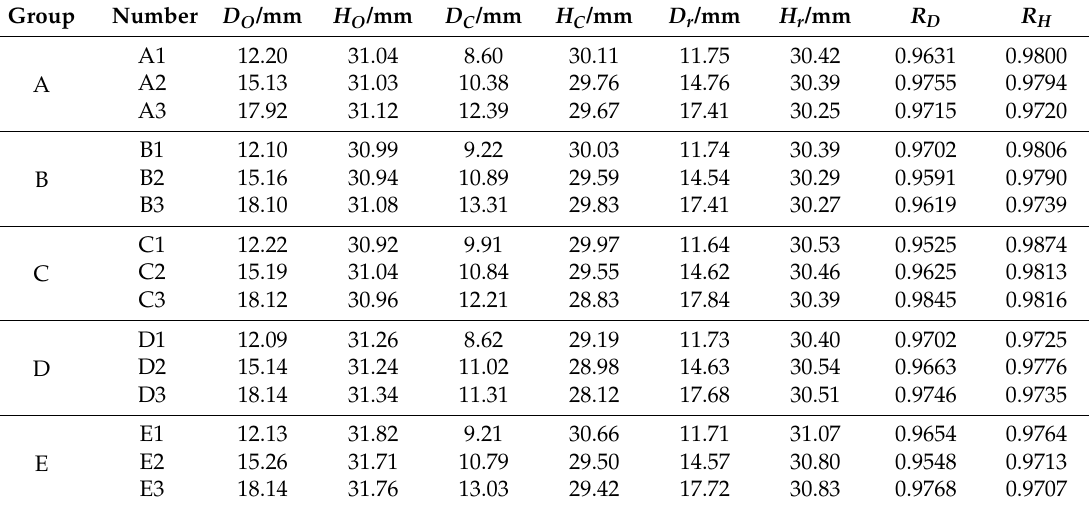
Table 2. SME experimental results of 3D-printed PLA vascular stents.